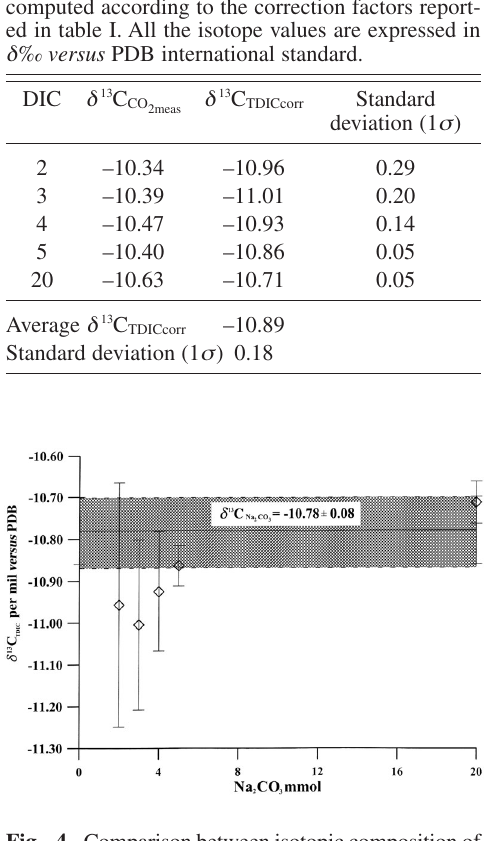
Fig. 4. Comparison between isotopic composition of solid Na 2 CO 3 and Na 2 CO 3 aqueous standard solution at different DIC concentration (2, 3, 4, 5 and 20 mmol/l). The error bar indicates the standard deviation of at least eight measurements for each of the aqueous solutions. Mean δ 13 C TDIC values are corrected accord- ing to eq. (4.2) and table I. All the resulting δ 13 C TDIC values are very close to the carbon isotope composi- tion of the Na 2 CO 3 powder (dark area) the maximum difference being 0.23 δ per mil.